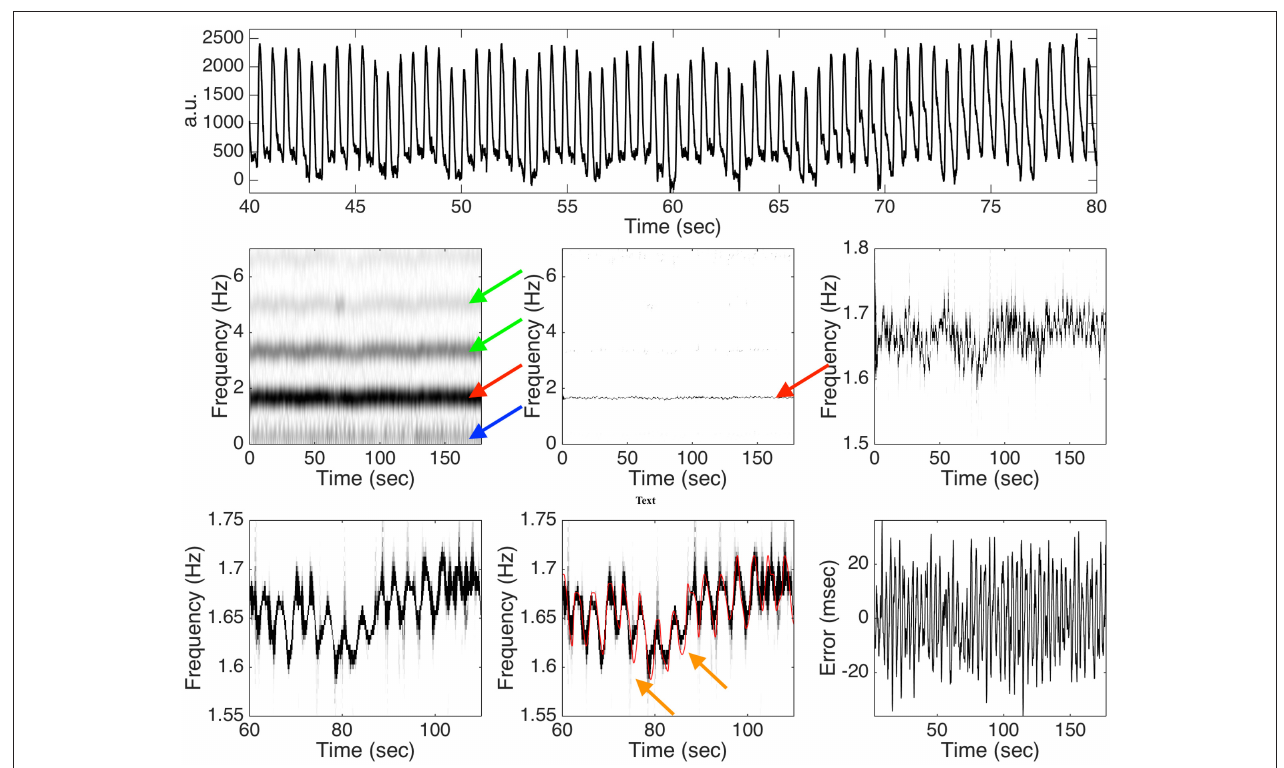
FIGURE 3 | Top panel : a subinterval of the simulated photoplethysmogram (PPG) signal with the instantaneous heart rate (IHR) determined from 0009_8min in the Capnobase database and 20dB signal-to-noise ratio. a.u. means “arbitrary unit.” Middle panel : the spectrogram determined by the short time Fourier transform (STFT) is shown on the left hand side, the de-shaped spectrogram is shown in the middle, and the zoomed in de-shaped spectrogram is shown on the right hand side. The red arrow indicates the band associated with the fundamental frequency of the hemodynamic component, the green arrows indicate those bands associated with the multiples of the hemodynamic component, and the blue arrow indicates the band associated with the fundamental frequency of the respiratory component. Bottom panel : a further zoomed in de-shape spectrogram is shown on the left hand side and the middle, with the ground truth IHR superimposed in the middle, and the error between the estimated IHR and the ground truth IHR is shown on the right hand side. The orange arrows indicate the possible oversmoothing effect of the deppG algorithm. See the main context for the interpretation of this